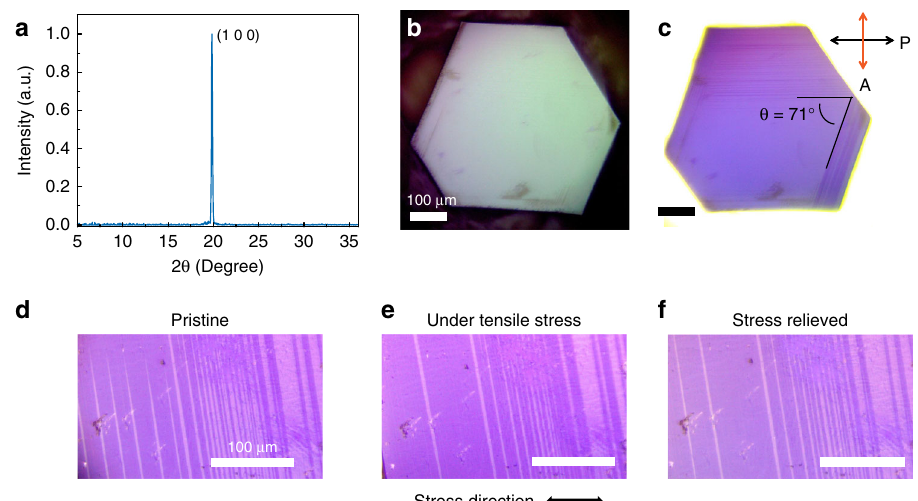
Fig. 1 Ferroelastic domain pattern observed by polarized optical microscope. a X-ray diffraction pattern of the as-grown CH 3 NH 3 PbI 3 (MAPbI 3 ) single crystals. b and c Regular ( b ) and polarized optical microscope ( c ) images of the MAPbI 3 single crystal; The two groups of domain patters intercept at about 71 o in the top (100) plane. d to f Polarized light optical images of domain pattern in MAPbI 3 single crystal before the application of external stress ( d ), under tensile stress ( e ), and after reliving the stress ( f ); The arrow in e indicates the applied stress direction. The scale bars are 100 μ